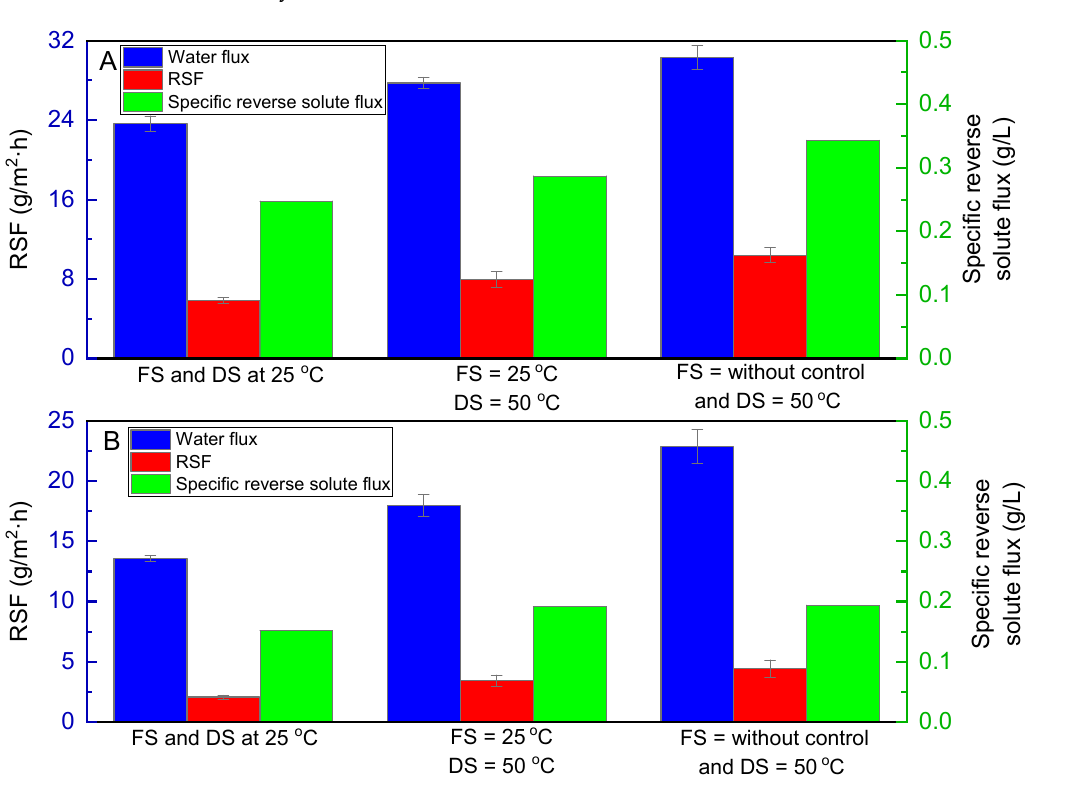
Figure 3. Water flux, reverse solute flux and specific reverse solute flux at different operating temperatures with DI water as the FS and ( A ) 0.6 M NaCl and ( B ) 1.2 M glucose as DS (note: temperature varying from 18 ◦ C to 42.2 ◦ C in FS without temperature control due to the heat transfer from DS to